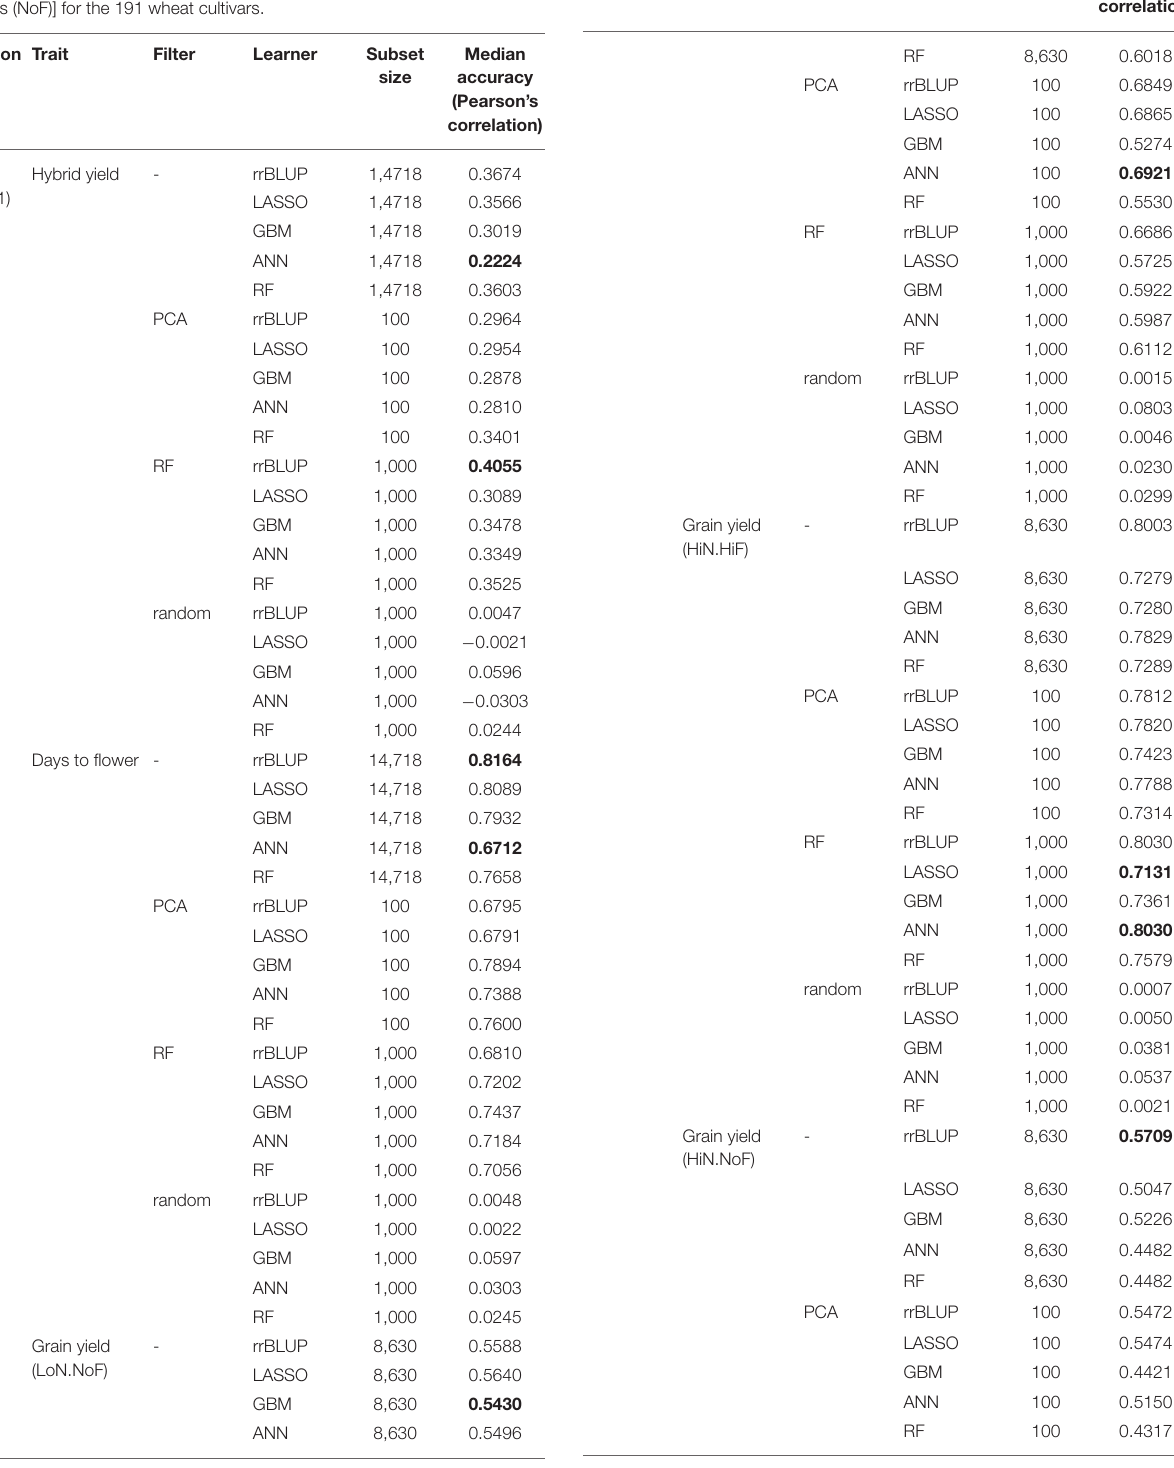
TABLE 1 | Median accuracy of cross-validation (CV) results using the Pearson correlation coefficient, over all pairs of feature scores in the 10-outer training sets obtained with different filter methods for feature selection (FS), of hybrid seed yield (SY), and days to flower for the B. napus panel and grain yield under three